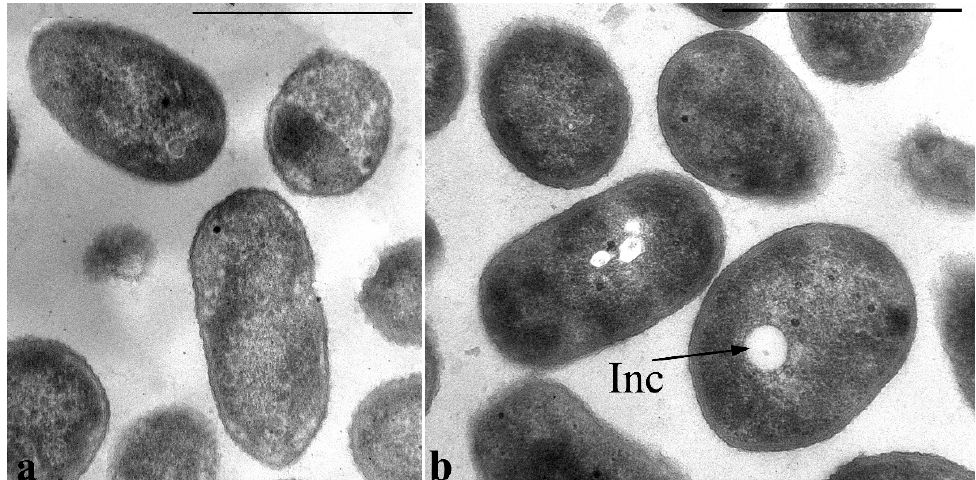
Figure 9. Transmission electron microscopy. Ultrathin sections of P. putida Ch 2 cells grown in an MS1 medium supplemented with caprolactam ( a ) and salicylate ( b ). Single small electron-transparent inclusions are rarely found in the cytoplasm of cells grown on salicylate ( b ). Designations: electron-transparent inclusions: Inc. Bar = 1 μ m.